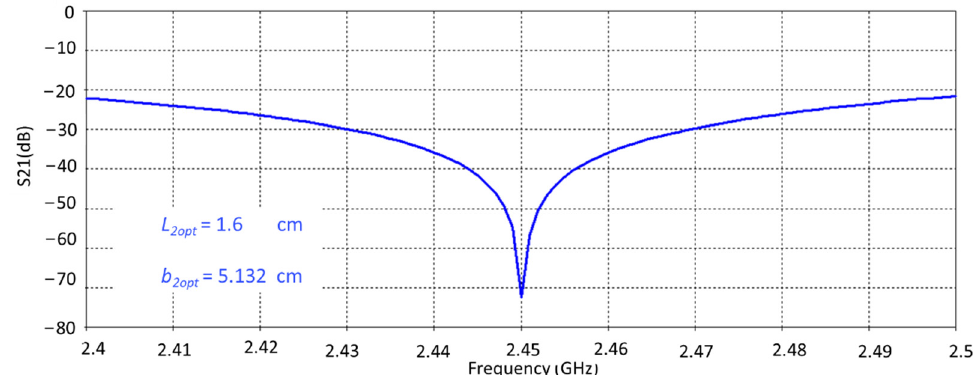
Figure 8. Simulated results of the optimized coaxial cavity acting as a bandstop filter. L 2 opt = 1.6 cm, b 2 opt = 5.132 cm.